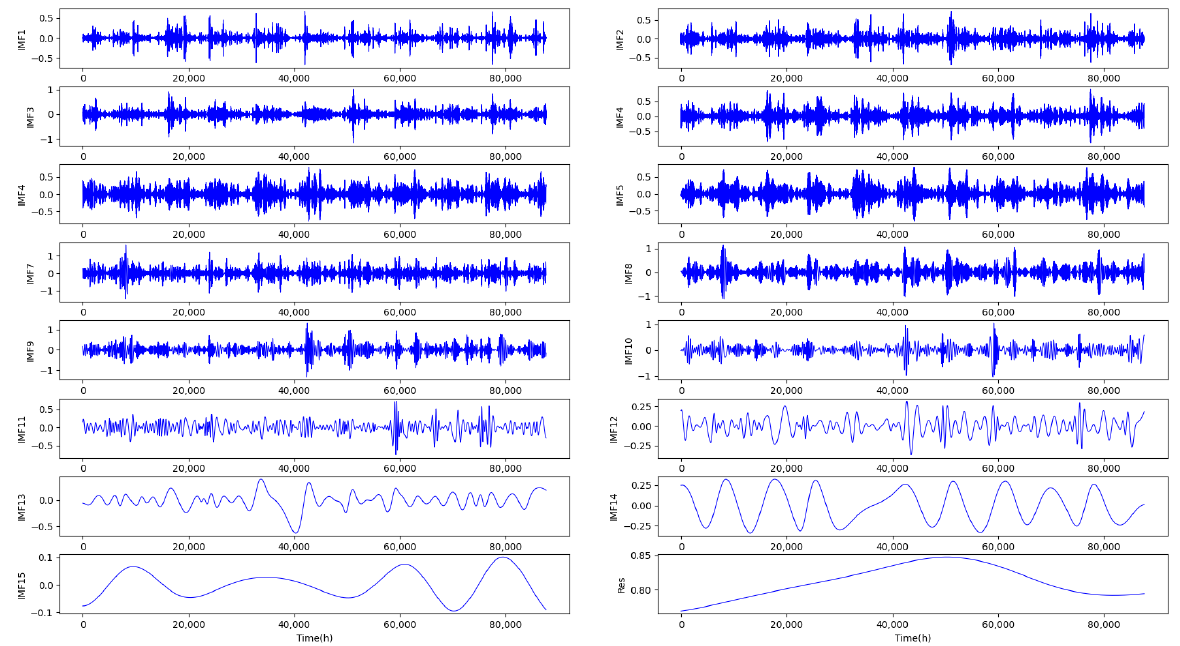
Figure 10. The EMD method was used to decompose the significant wave height results at position B.